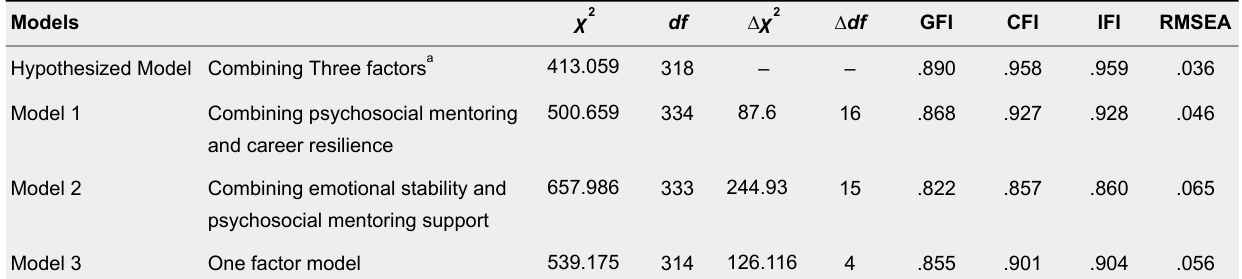
Confirmatory Factor Analysis of Measurement Models: Fit